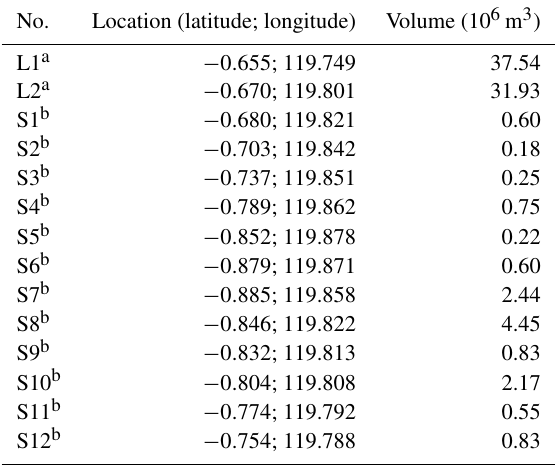
Table 3. Hypothesized landslide parameters (location and volume) in Palu